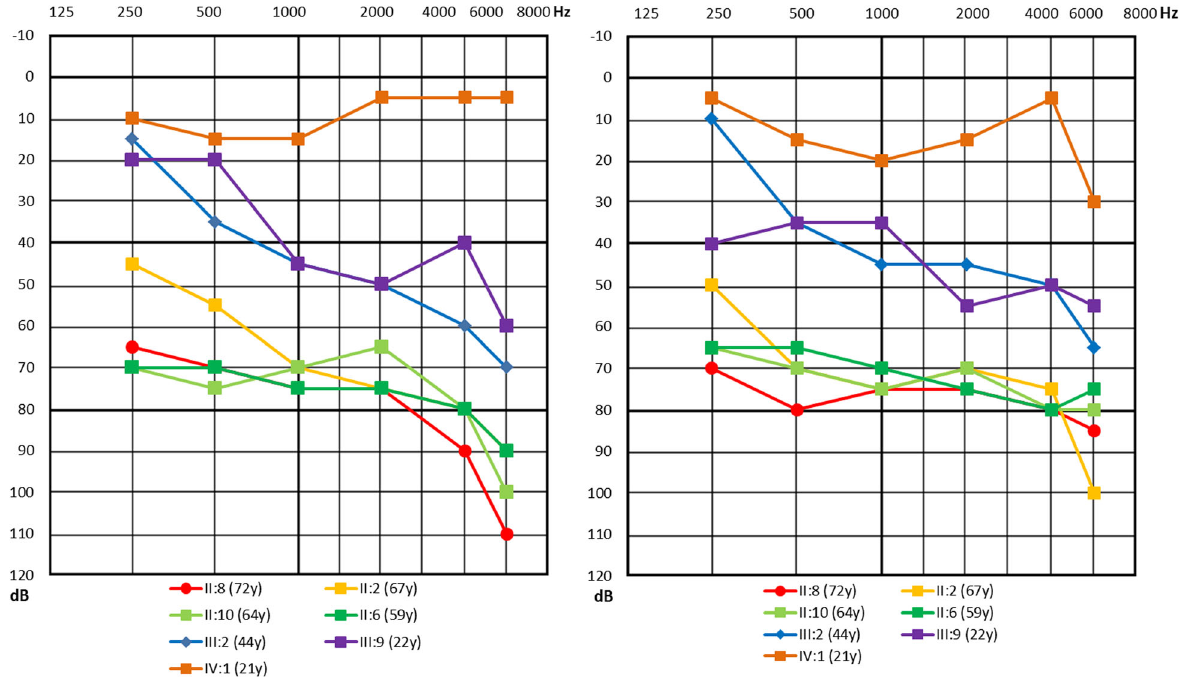
Fig. 2 Pure tone audiograms of the affected family members. Left chart – right ear, right chart – left ear. The number in the parentheses corresponds to the subject ’ s age at audiometric testing in this